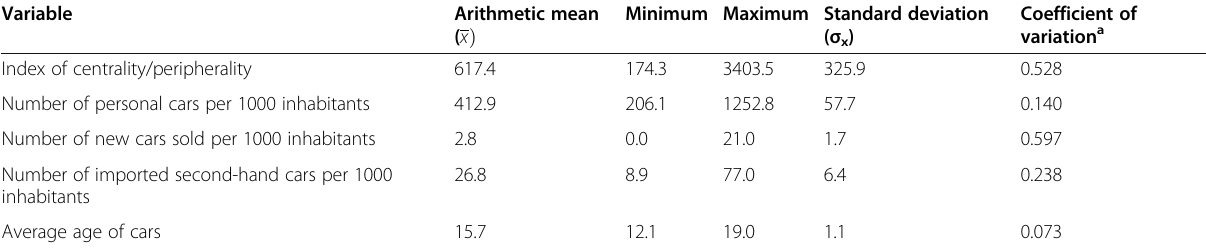
Table 2 Basic statistical characteristics of variables Variable